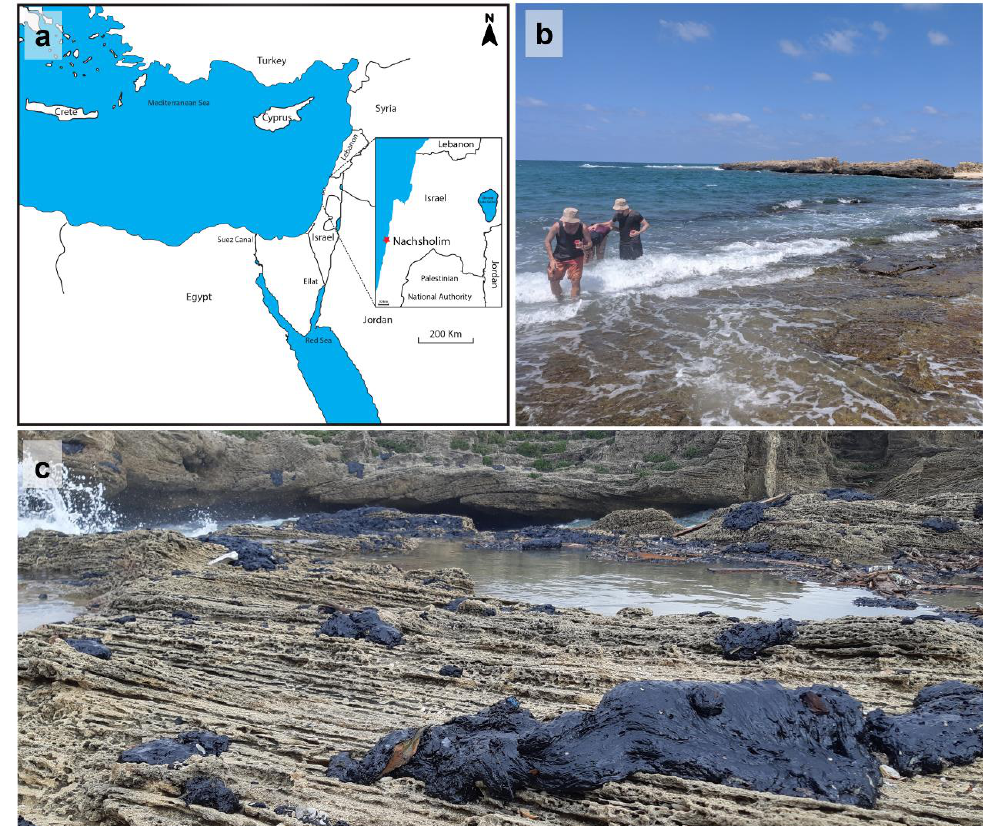
Figure 1. ( a ) Location map of the studied site, the Natural Reserve Nachsholim, at the northern Mediterranean coast of Israel. ( b ) View of the hard bottom shallow habitat of Nachsholim during the August 2021 sampling campaign. ( c ) Nachsholim Site abrasion platforms covered with tar after the February 2021 spill event.